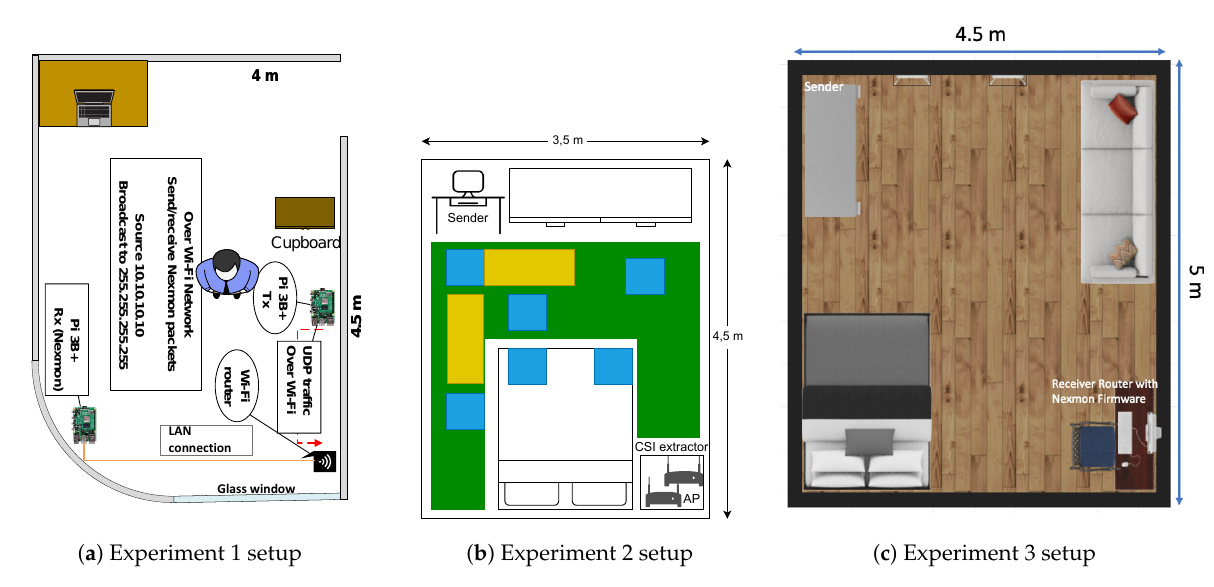
Figure 2. Experimental